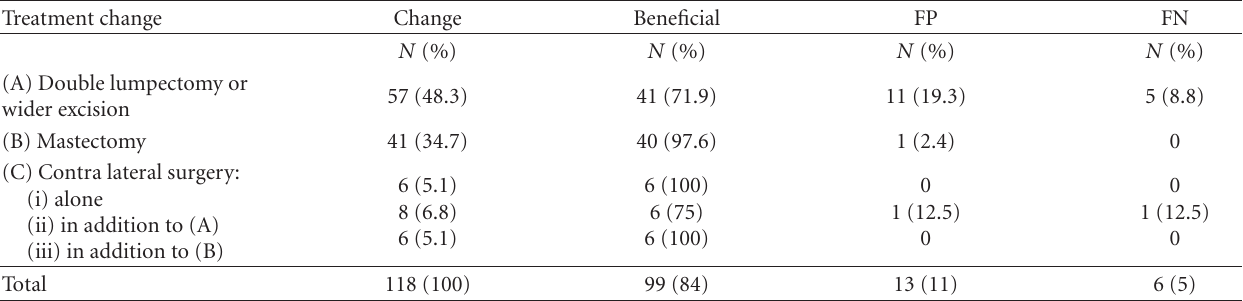
Table 4: Change in surgical management based on CE-MRM.